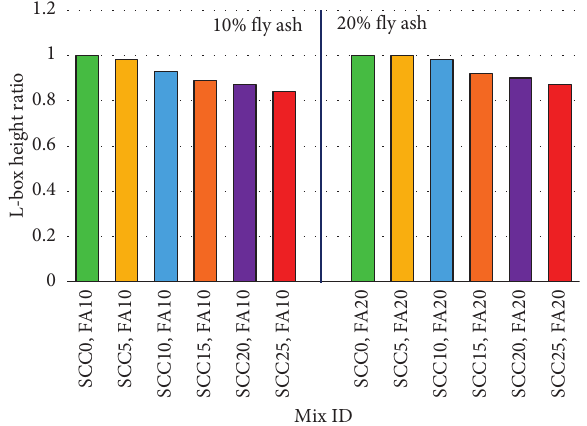
Figure 4: L-box ratio test values for the fresh concrete.